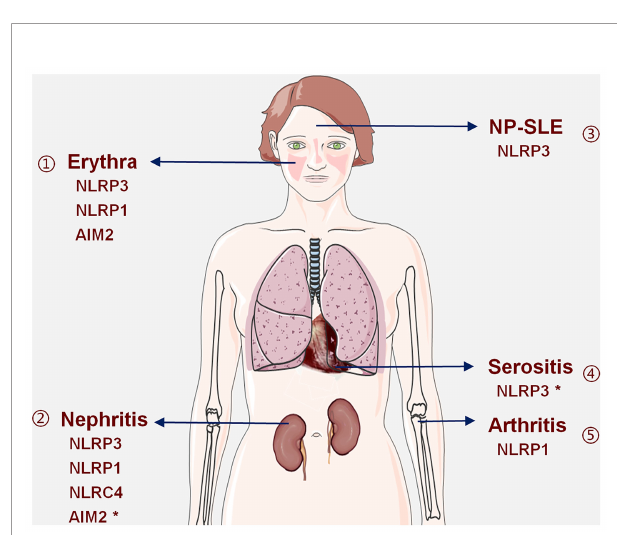
FIGURE 2 | In fl ammasomes are involved in SLE-related organ damage: available evidence shows that (1) NLRP3, NLRP1, and AIM2 in fl ammasomes are involved in erythrina; (2) NLRP3, NLRP1, NLRC4, and AIM2 in fl ammasomes are involved in LN, and the role of AIM2 in fl ammasome is complex and may have a protective effect; (3) the NLRP3 in fl ammasome is involved in the pathogenesis of NP-SLE; (4) the NLRP3 in fl ammasome may play a promotive or inhibitory role in serositis; (5) the NLRP1 in fl ammasome is involved in arthritis. *Indicates that this in fl ammasome has a dual